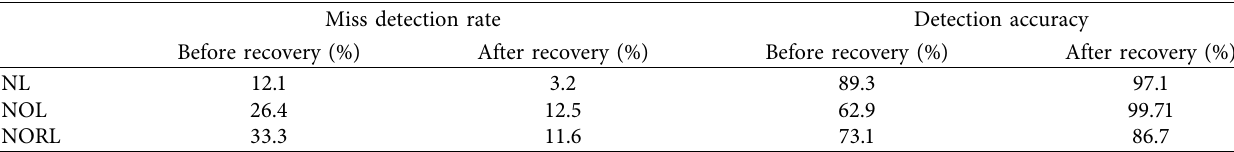
Table 5: Comparison table of missed detection rate and target detection accuracy in three